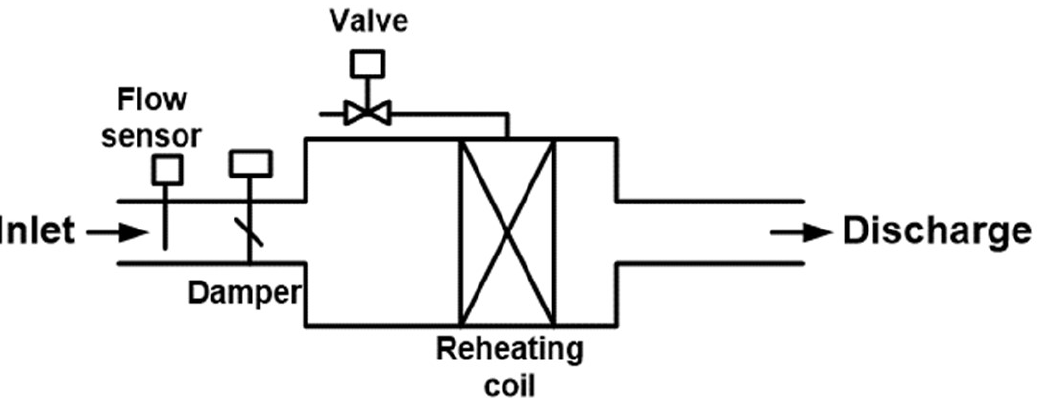
Figure 1. Throttling VAV terminal unit [16].